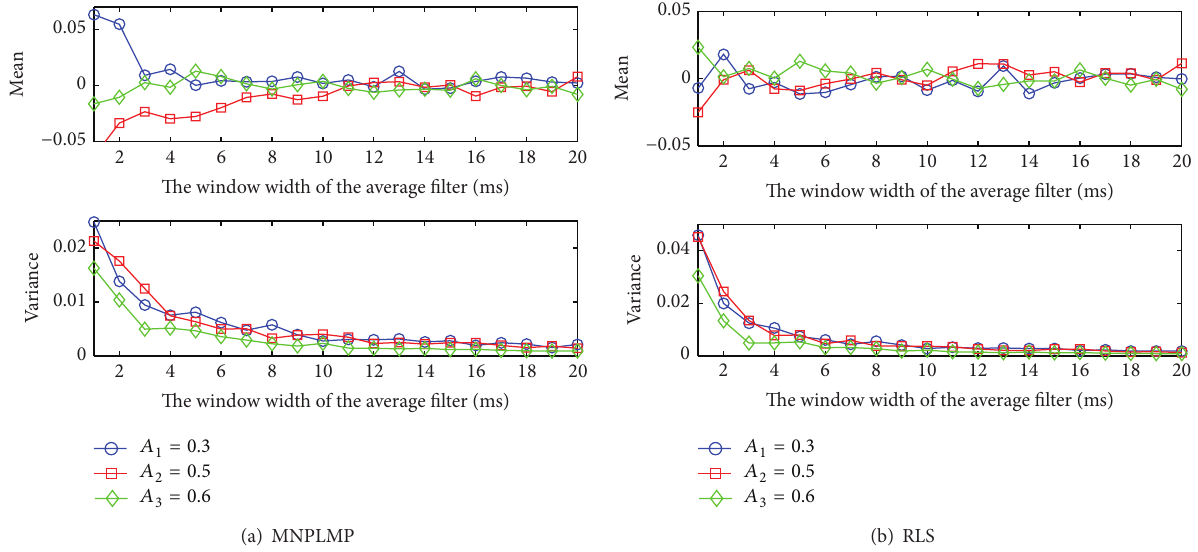
Figure 10: Multipath amplitude estimation errors in various average filtering times under the AWGN